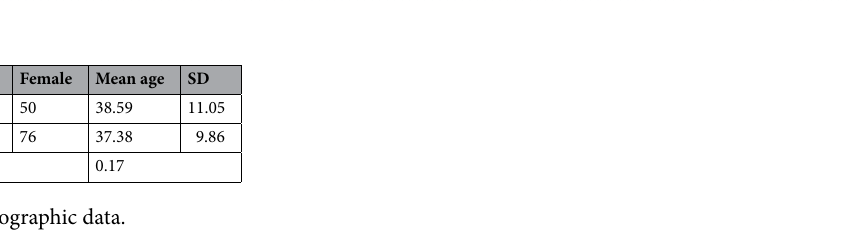
Table 1. Forward (F) and reverse (R) primers for functional polymorphisms uVNTR, 5-HTTLPR and STin2.